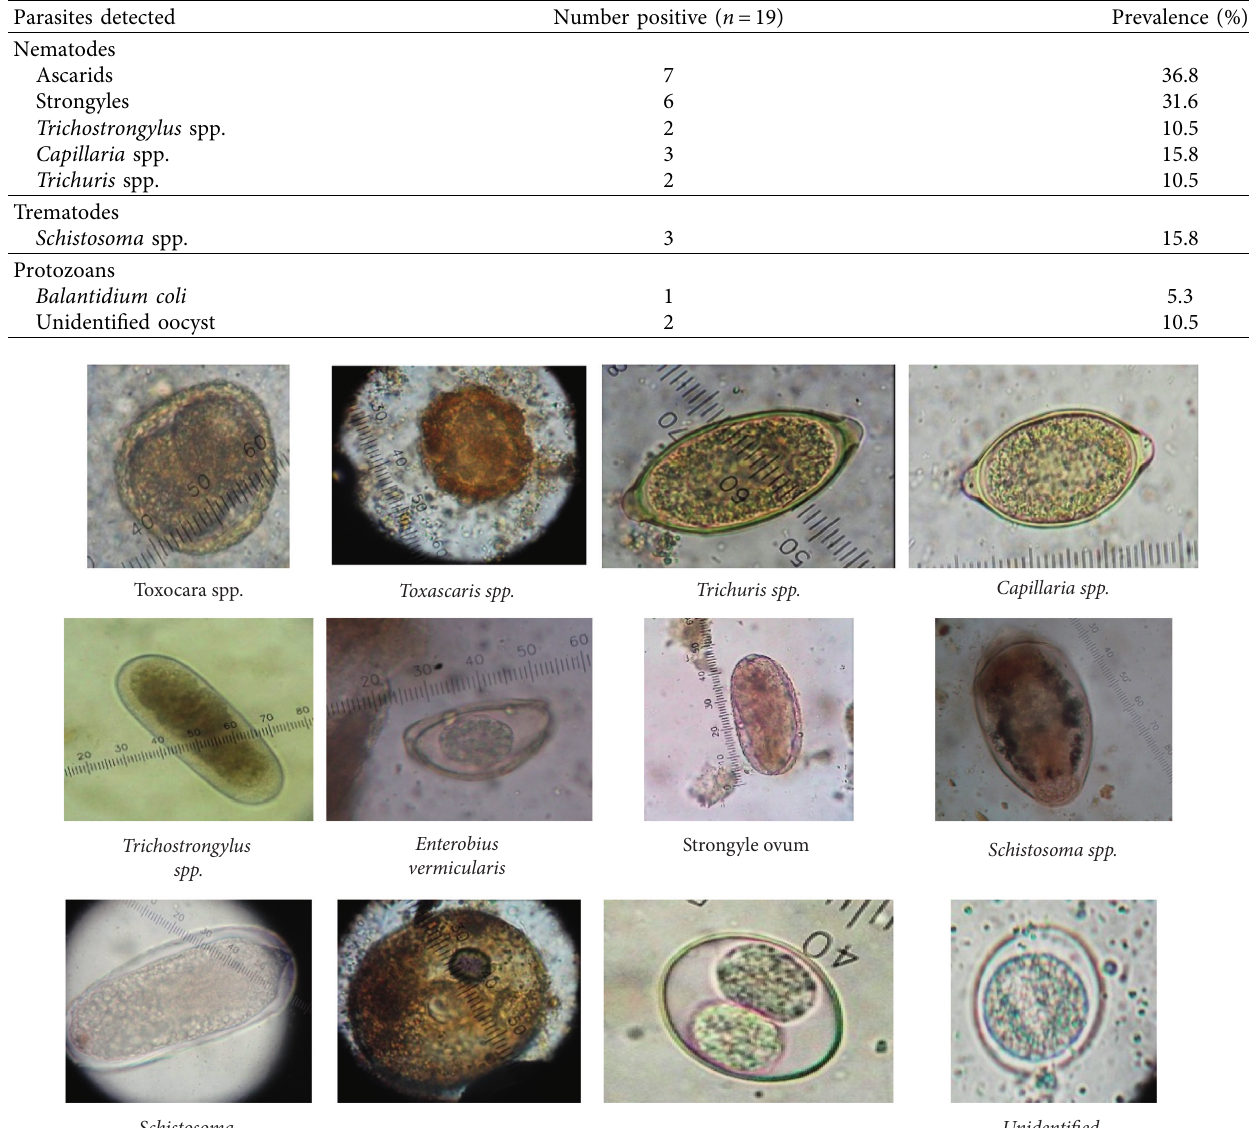
Table 1: Prevalence of gastrointestinal parasites among the captive ocelot population in Trinidad.